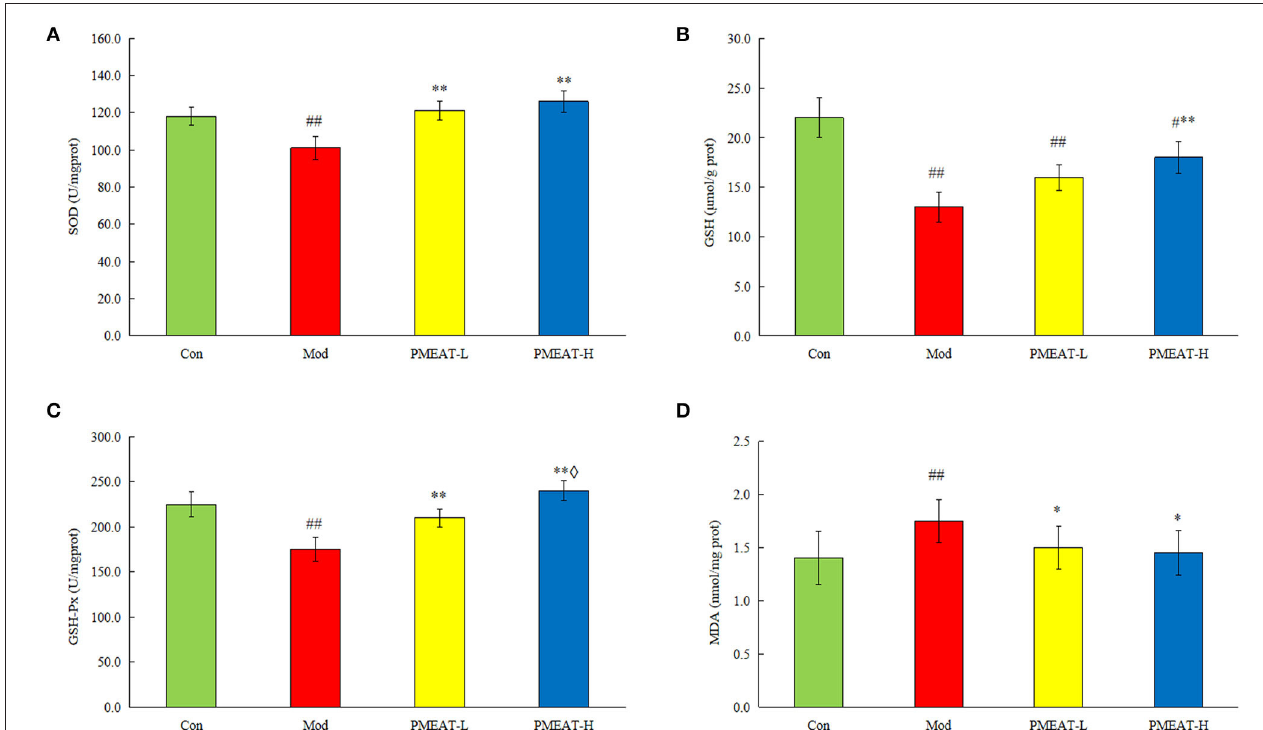
FIGURE 6 | Effect of PMEAT treatment on liver tissue SOD, GSH, GSH-Px, MDA, and 8-ISO-PGF2 α . (A) Concentration of SOD in liver tissue of four observed groups. (B) Concentration of GSH in liver tissue of four observed groups. (C) Concentration of GSH-Px in liver tissue of four observed groups. (D) Concentration of MDA in liver tissue of four observed groups. One-way ANOVA was applied to examine the differences among four groups. Superscript # and ## indicate statistically significant differences compared with the Con group ( p < 0.05) and ( p < 0.01), respectively. Superscript * and ** indicate statistically significant differences compared with the Mod group ( p < 0.05) and ( p < 0.01), respectively. Superscript ♦ indicates a statistically significant difference compared with the PMEAT-L group ( p < 0.05). Con, control group; Mod, model group; PMEAT-L, low-dose PMEAT group; PMEAT-H, high-dose PMEAT